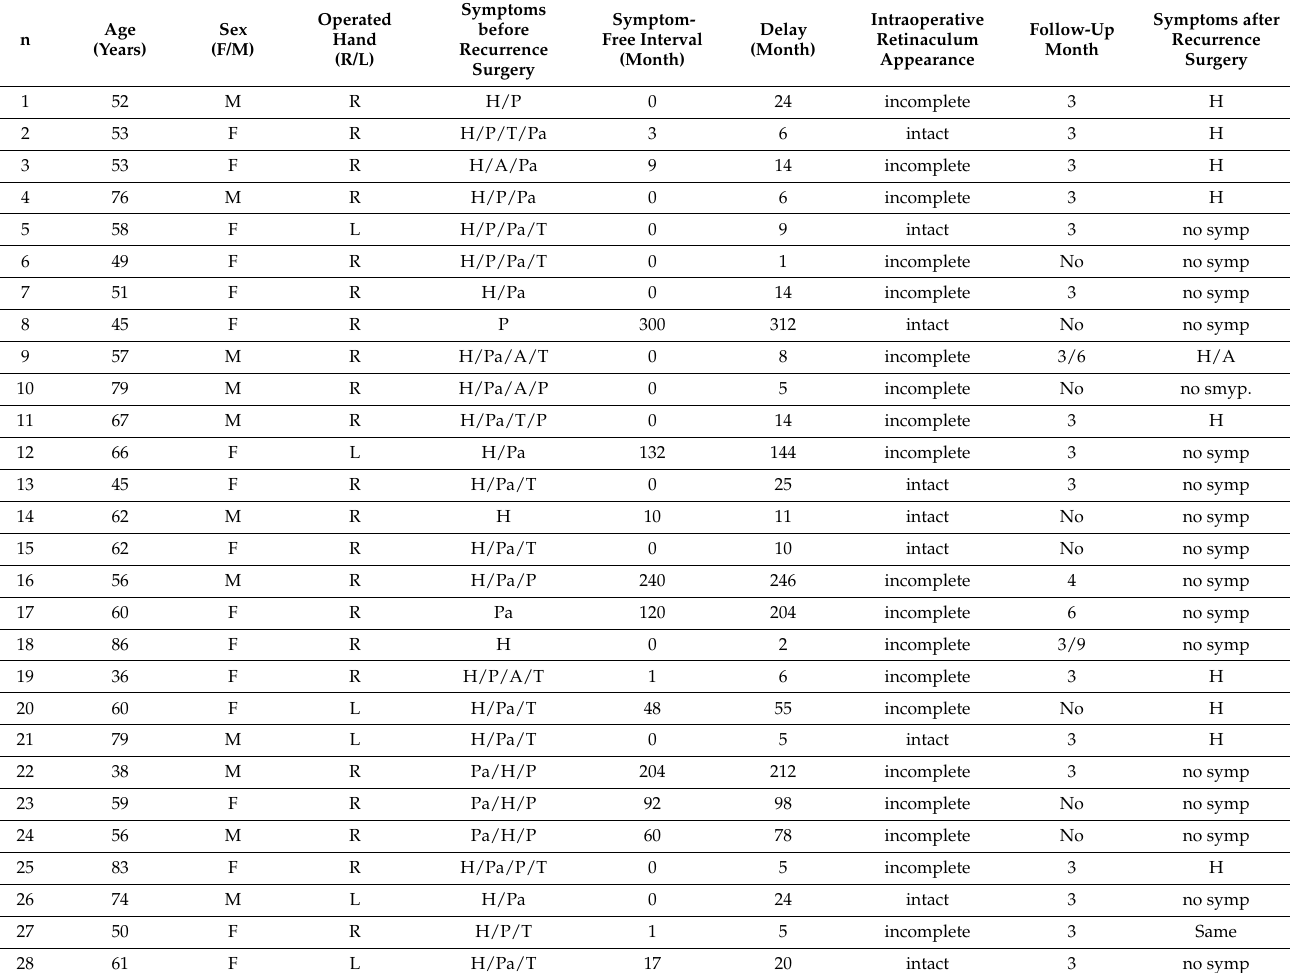
Table 4. Postoperative outcomes in 28 revision surgery